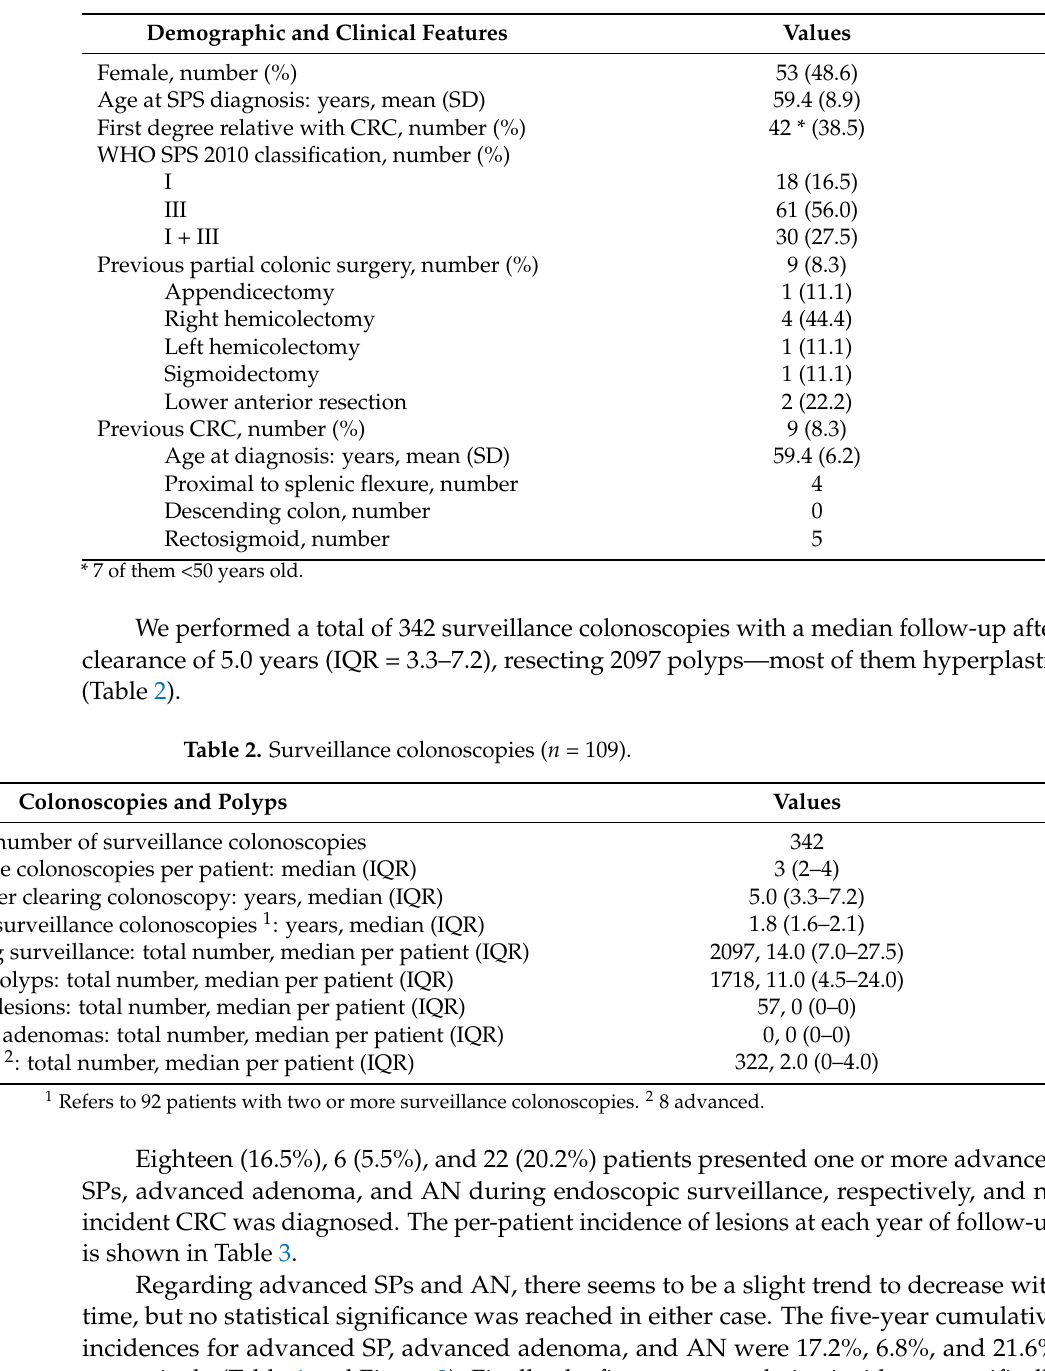
Table 1. Baseline characteristics of patients with SPS included in the surveillance ( n = 109).